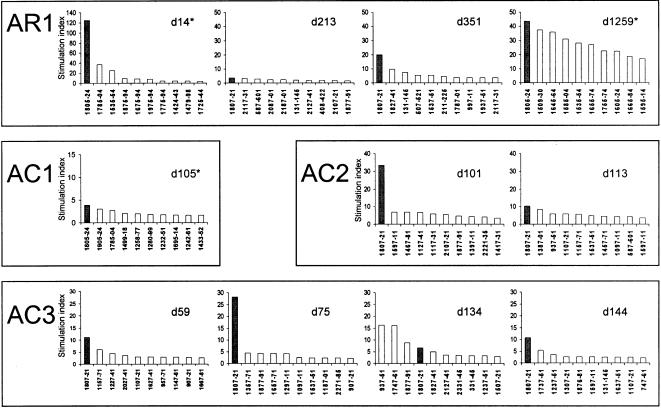
Relative immunodominance of epitope HCV 1805-24 in the acute HCV cohort.Ex vivo proliferation assays were performed on PBMC taken from the persons indicated over time. The responses to peptides including the sequence 1807-18 are marked with a dark bar. The ten peptides inducing the strongest proliferative response are shown in descending order with regard to the strength of the response. Asterisks indicate time points when the NS3-helicase/NS4 peptide library (covering aa 1207–2014) was used; all other assays were performed with a peptide library covering the entire HCV genome. A SI>3.0 was considered significant.